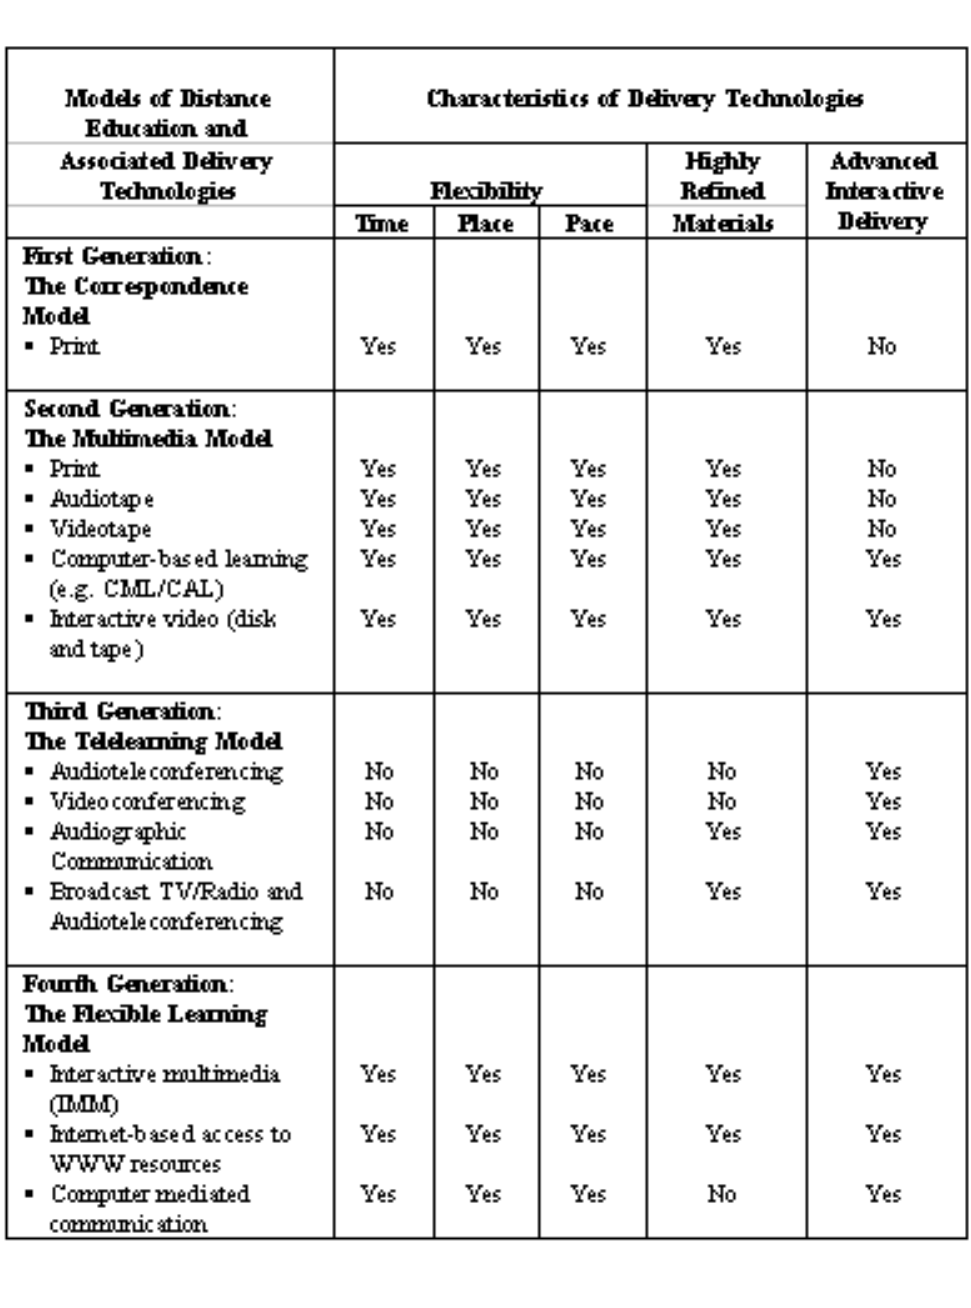
Table1: Models of Distance Education – A Conceptual Framework